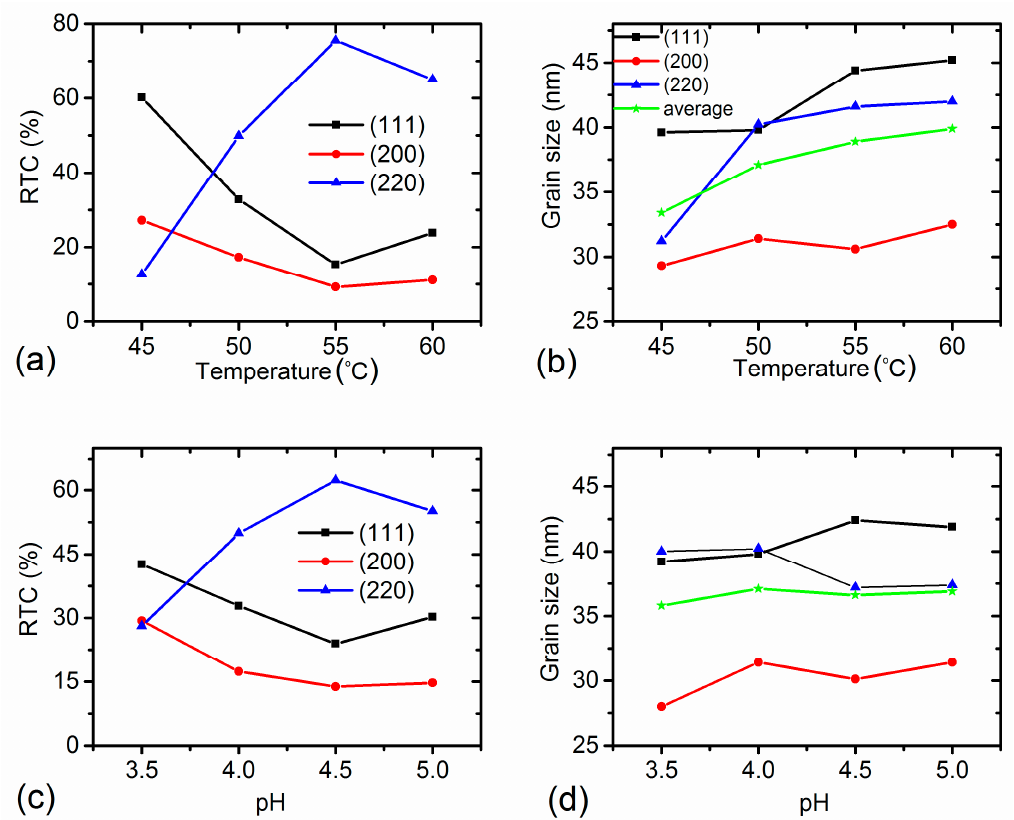
Figure 6. Variation of RTC (hkl) and grain size from different diffraction peaks: ( a , b ) with bath temperature; ( c , d ) with pH.